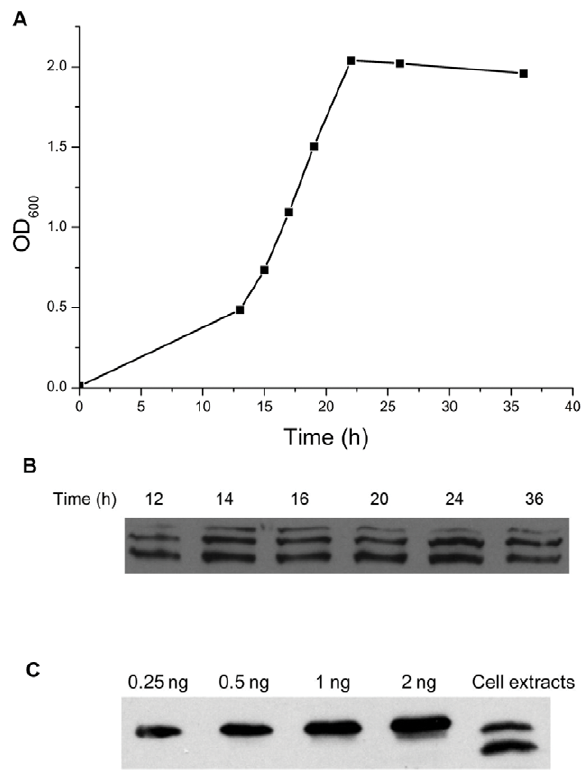
Figure 2. Identification of MSMEG_2731 invivo . (A) The growth curve of M. smegmatis . A 1% inoculum of bacteria, freshly grown to an OD 600 < 2.0 was collected and washed with fresh 7H9 broth. It was then added to fresh 7H9 broth to give an OD 600 < 0.01 and further incubated with shaking (150 rpm) at 37 u C for 48 h. The absorbance of the culture was monitored with a spectrophotometer at given intervals. (B) Cells harvested after 12 h, 14 h, 16 h, 20 h, 24 h and 36 h of incubation were resuspended in fresh 7H9 broth to give an OD 600 < 1.0. Then, 1 ml of the culture suspension was centrifuged to collect the cells. The pellets were resuspended in 40 m l of Laemmli sample buffer and boiled at 100 u C for 10 min. Samples were electrophoresed on an SDS-PAGE gel and then transferred to a nitrocellulose membrane. Anti-MSMEG_2731 serum was utilized to detect the expression level of MSMEG_2731. (C) Estimation of the cellular concentration of MSMEG_2731 by quantitative Western blotting. Lanes 1 to 4 are recombinant MSMEG_2731 loaded at the indicated amounts. Lane 5 shows native MSMEG_2731 in exponentially- growing M. smegmatis cells (OD 600 =0.3).